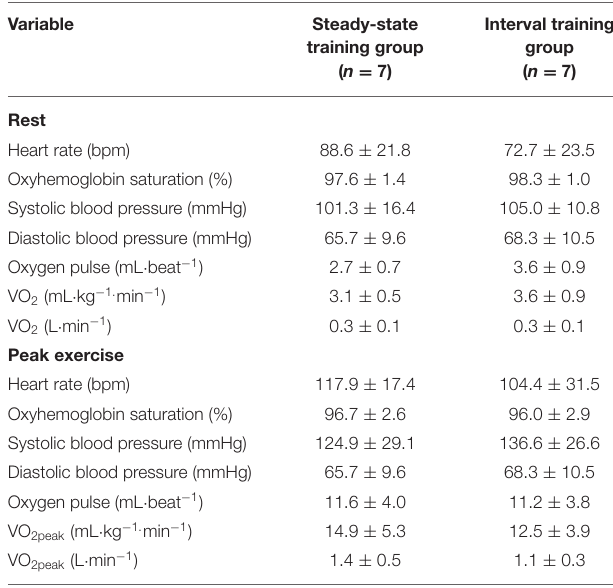
TABLE 2 | Cardiorespiratory responses at rest and during incremental to maximal exercise testing (values are means ±